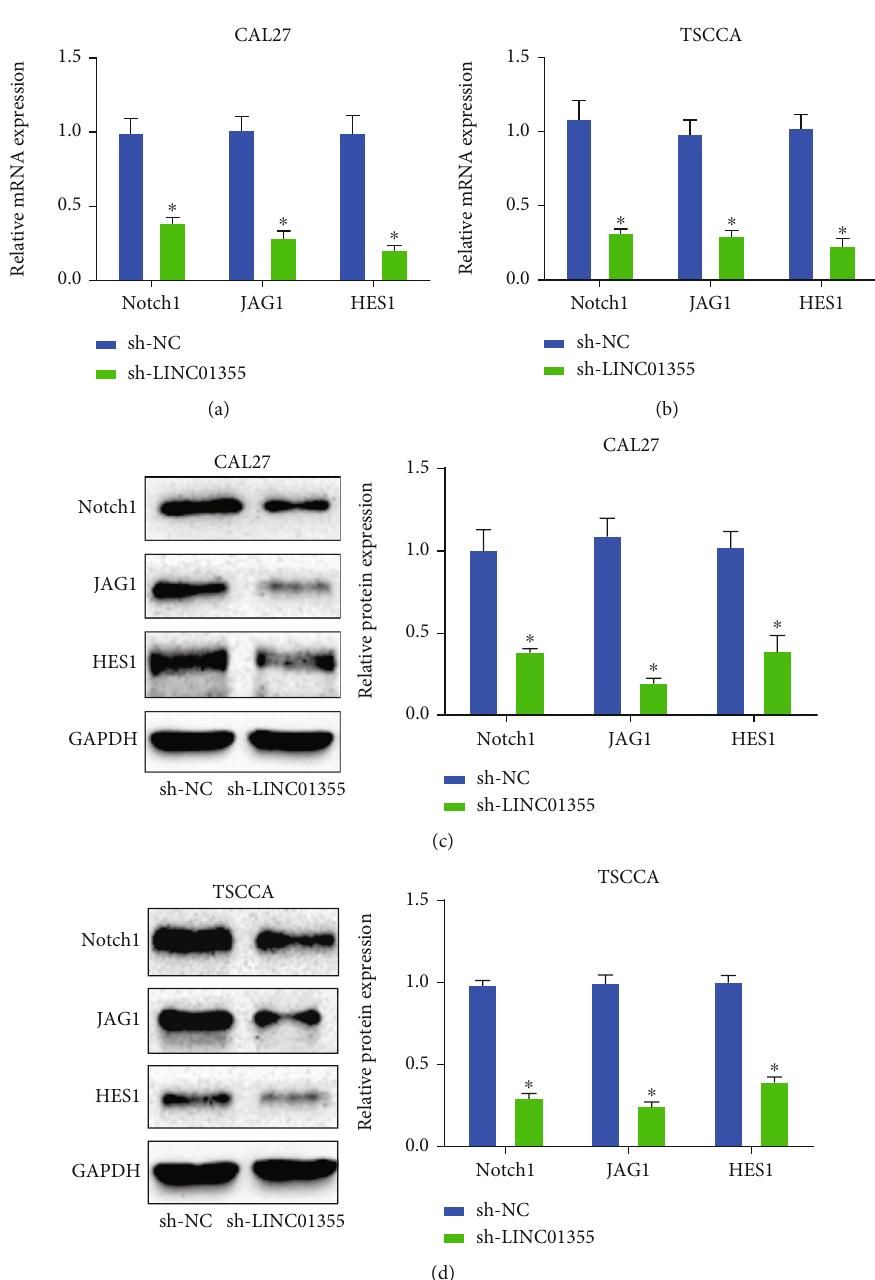
Figure 5: Knockdown of LINC01355 signi fi cantly repressed Notch signal in OSCC cells. (a, b) qRT-PCR analysis of Notch-1, JAG-1, HES-1 mRNA expression in OSCC cells transduced with LINC01355 shRNA or NC. (c, d) Western blotting analysis of Notch-1, JAG-1, HES-1 protein expression in OSCC cells transduced with LINC01355 shRNA or NC. ∗ p < 0 : 05